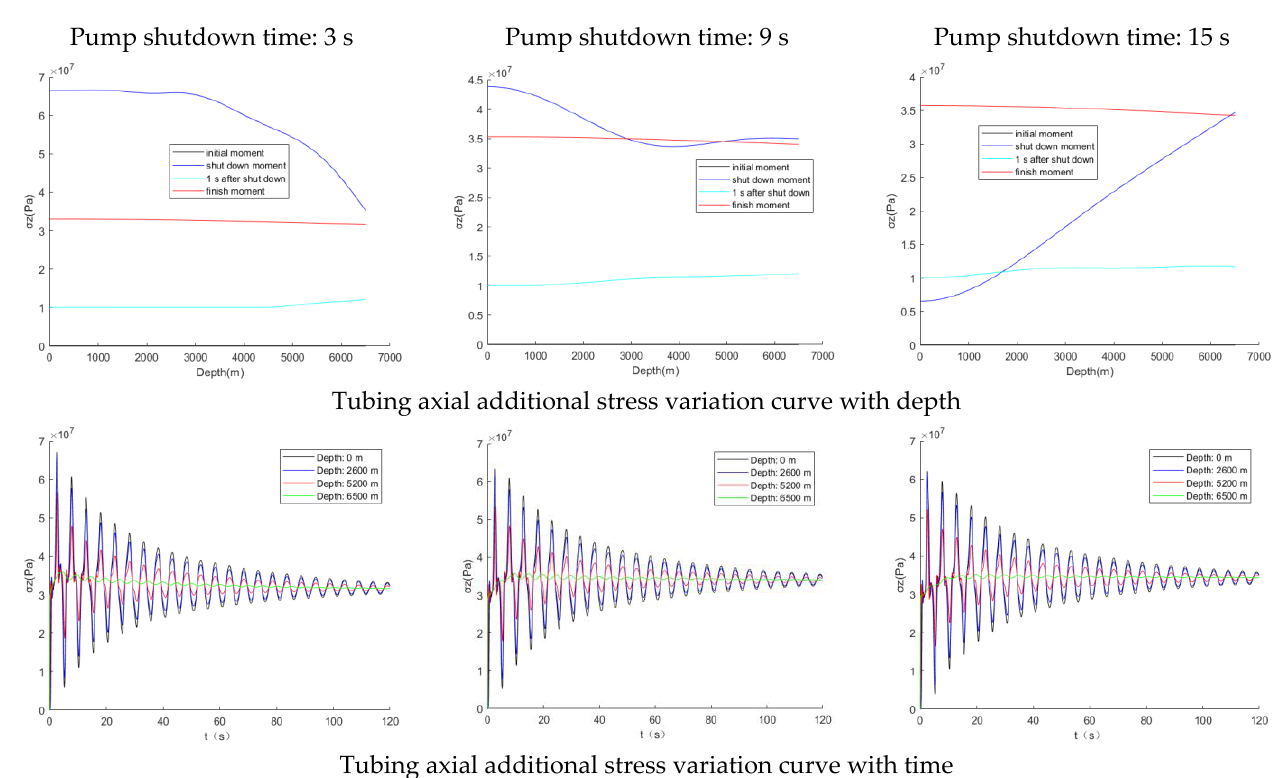
Figure 8. Variation curve of tubing axial additional stress under different pump shutdown time.